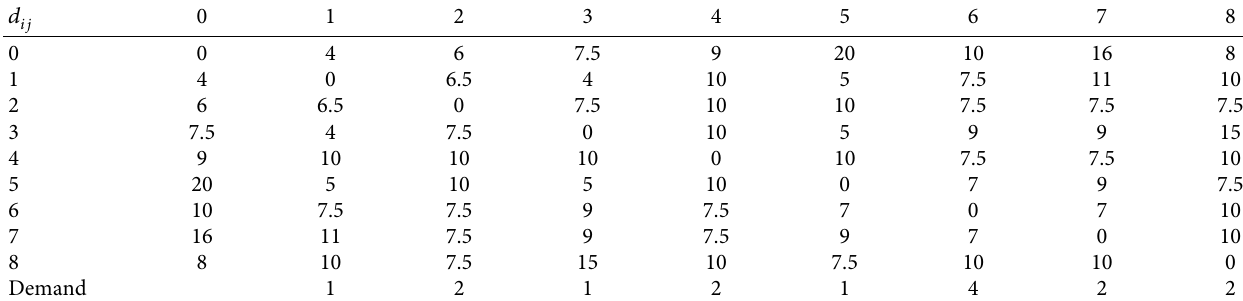
Table 1: Customer point distance and demand of each customer point [15].